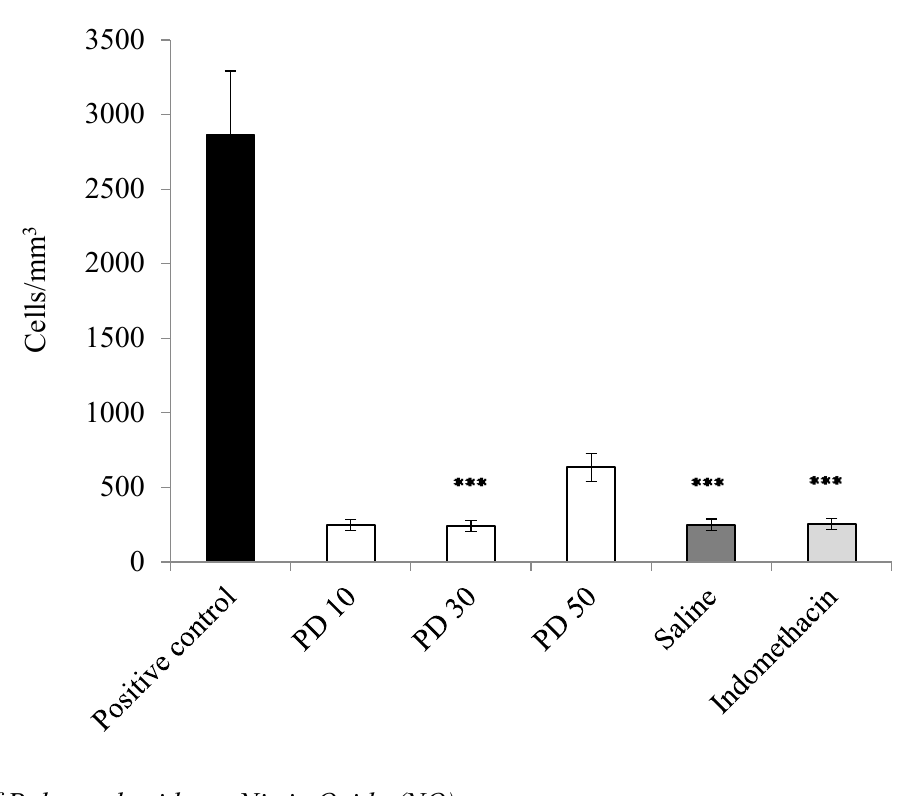
Figure 3. Anti-inflammatory effect of P. dermoporus extract (PD) on carrageenan-induced pleurisy. The number of pleural exudate leukocytes in carrageenan-induced Wistar rats. The experimental animals were treated with P. dermoporus extract at 10 mg/kg (PD 10), 30 mg/kg (PD 30) and 50 mg/kg (PD 50). Data obtained from animal experiments are expressed as the mean ± SD. The differences between treatment and control were tested by ANOVA. A value of (***) p < 0.001 was considered statistically